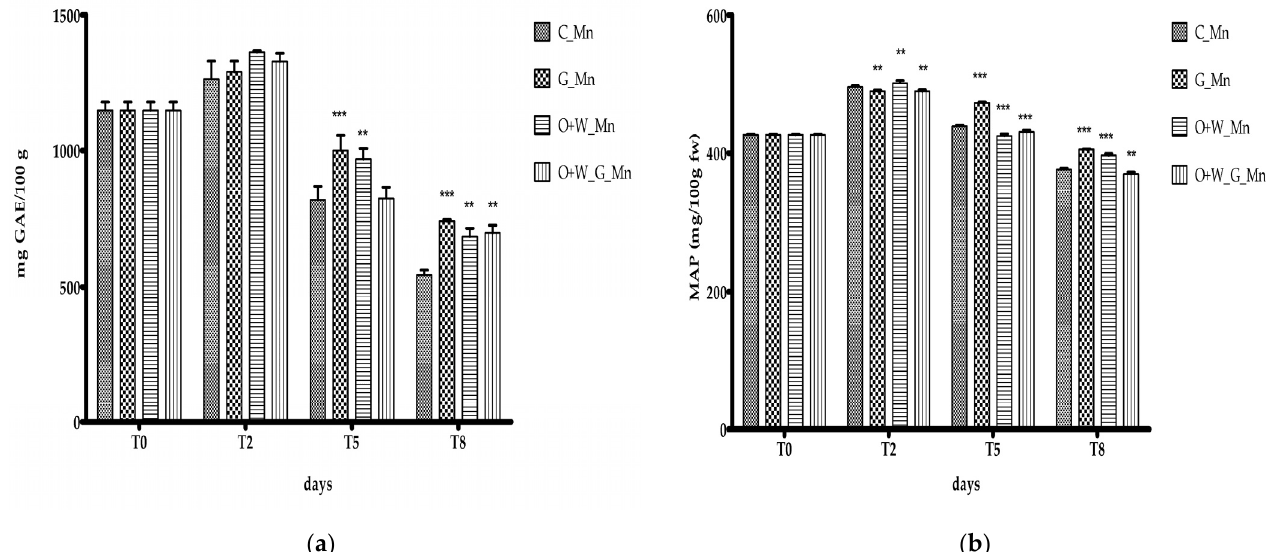
Figure 4. The effects of edible coatings on total phenol content (mg GAE/100 g fw) ( a ) and monomeric anthocyanin pigments (mg/L) ( b ) in mulberry fruits over 8 days of cold storage. All values are expressed as the means ± SD (n = 3). The statistical significance (** p < 0.01; *** p < 0.001) was determined compared to the control group at the corresponding time.